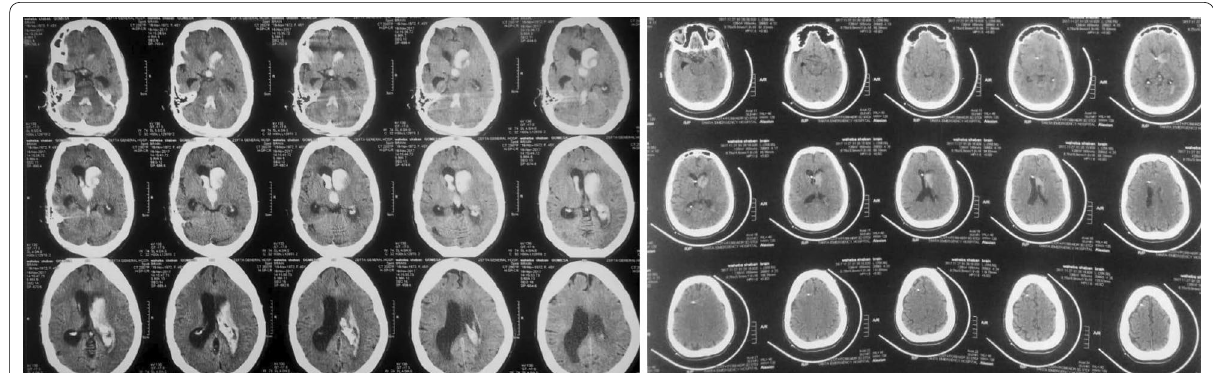
Fig. 1 A 56-year-old female presented with intraventricular haemorrhage managed by right-sided external ventricular drain (EVD). Left: axial CT scan before insertion of EVD drain shows blood is filling the left ventricle and dilating both lateral ventricle, third and fourth ventricles with left basal caudate intra-cerebral haematoma. According to Graeb’s grading system intraventricular haemorrhage graded as severe with score 9. Right: axial CT scan 7 days after EVD drain insertion shows the end of the drain is seen inserted into the frontal horn of the right lateral ventricle with near-complete drainage of intraventricular blood (successful drainage) and decrease in size of left caudate intra-cerebral